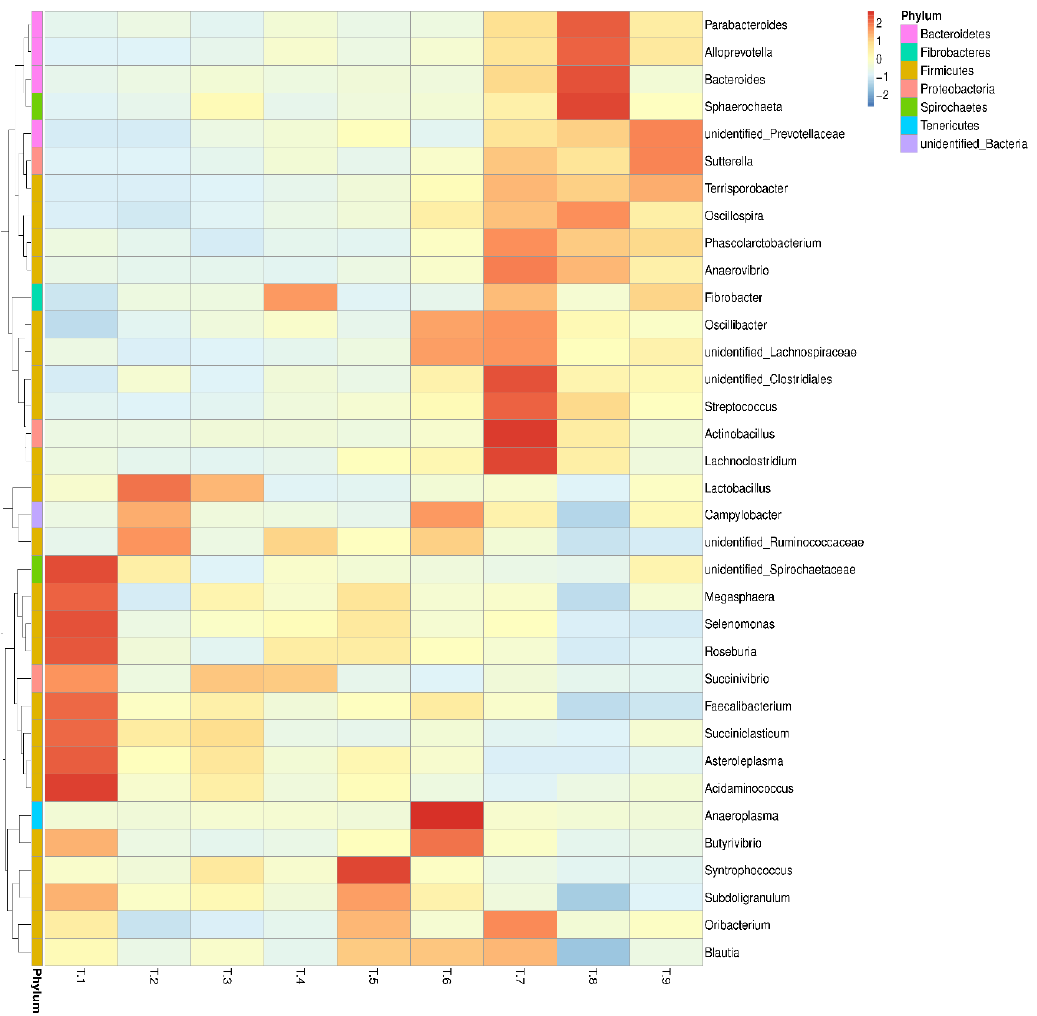
Figure 2. The bacterial community heatmap of the top 35 bacteria at genus level. The different colors represented the relative abundance of bacteria in nine dietary treatments.